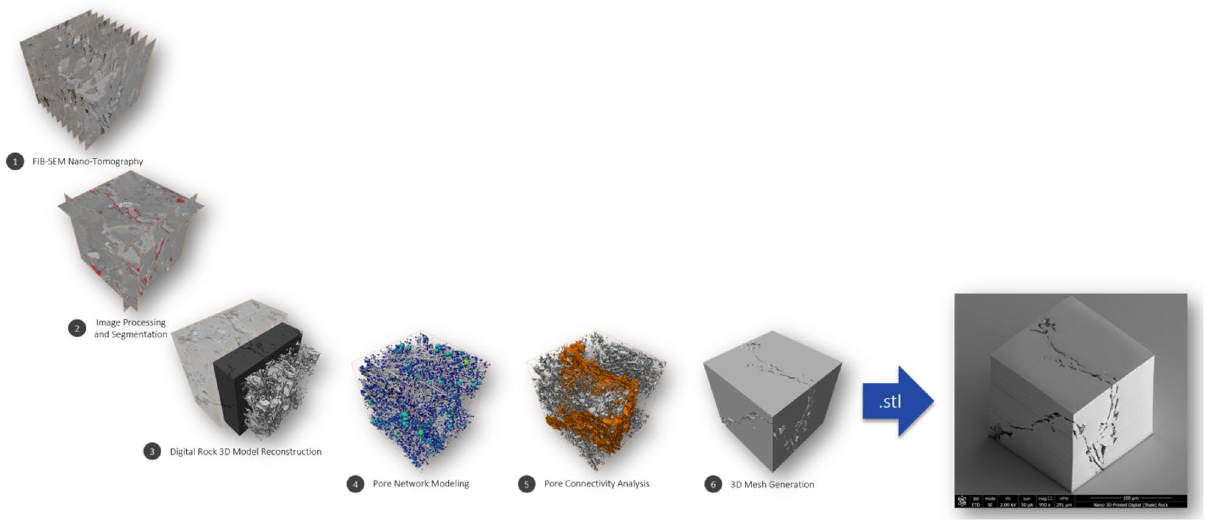
Figure 9. Summary of a workflow that allows to reconstruct pore network 3D models (suitable for nano-3D- printing) from processed and segmented image datasets collected using e.g., nanoscale-resolution FIB-SEM nano-tomography.